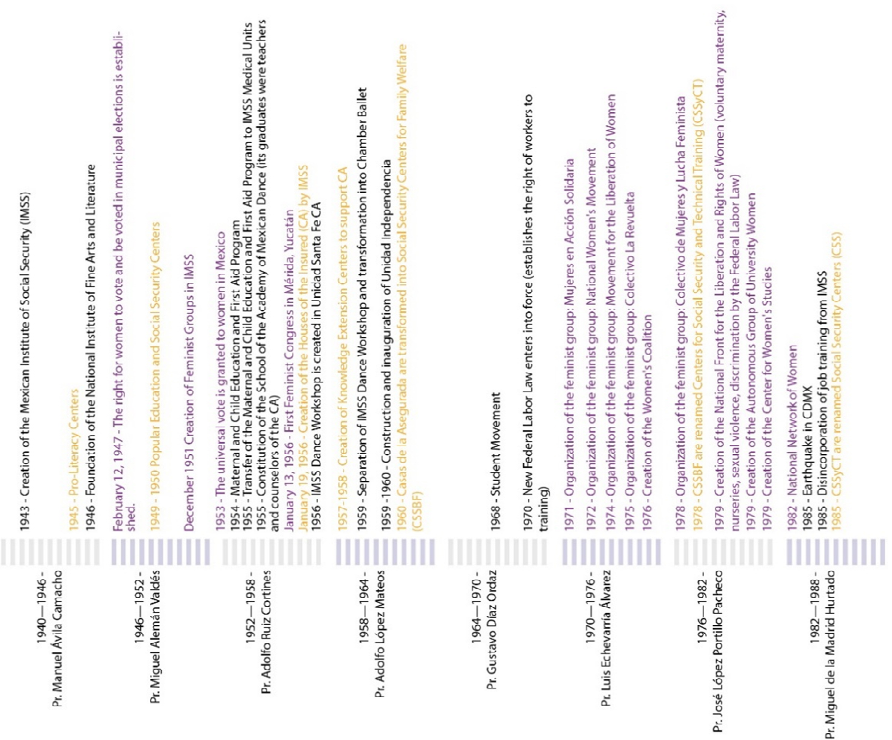
Figure 2. Timeline representing the historical context in Mexico, in which Casas de la Asegurada were developed. Source: own creation,